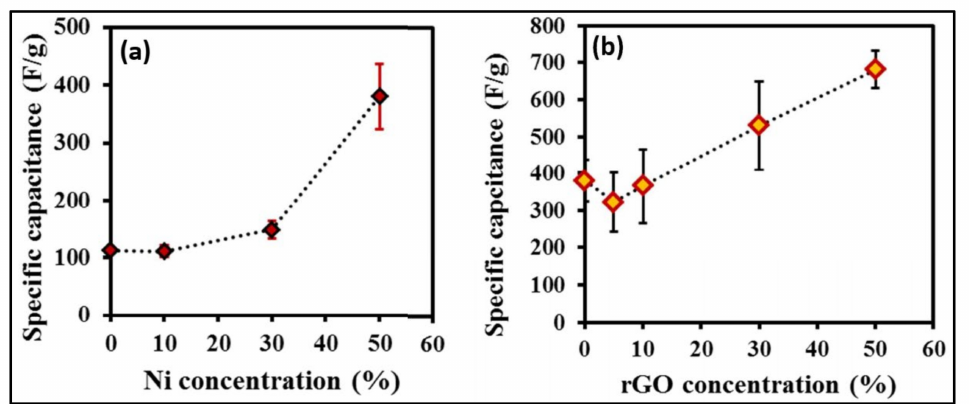
Figure 7. ( a ) Specific capacitance as a function of the Ni doping concentration and ( b ) specific capacitance as a function of rGO concentration in MOF-5 in 1 M KOH [26]. Reprinted (adapted) with permission from Parama Chakraborty Banerjee, Derrek E. Lobo, Rick Middag, et al. Electrochemical Capacitance of Ni-doped Metal-Organic Framework and Reduced Graphene Oxide Composites: More than the Sum of Its Parts. ACS Appl. Mater. Interfaces 2015, 7, 6, 3655–3664). Copyright (2015) American Chemical